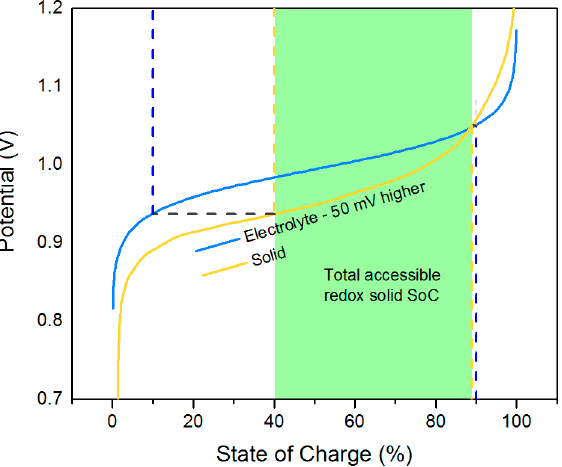
Figure 3. Accessible SoC of solid booster as a function of electrolyte potential. 𝐸 (cid:2869)(cid:2868) is 50 mV higher than 𝐸 (cid:2870)(cid:2868) .